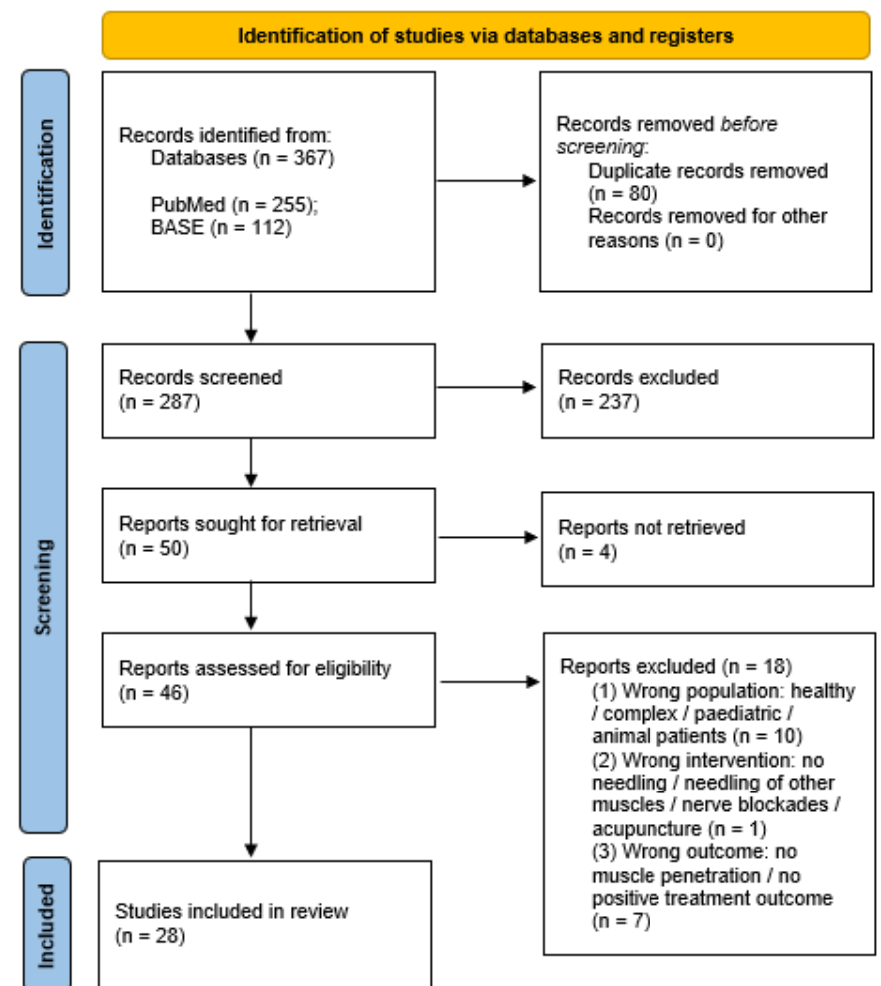
Figure 1. A PRISMA flow diagram of the literature screening and selection processes [19].